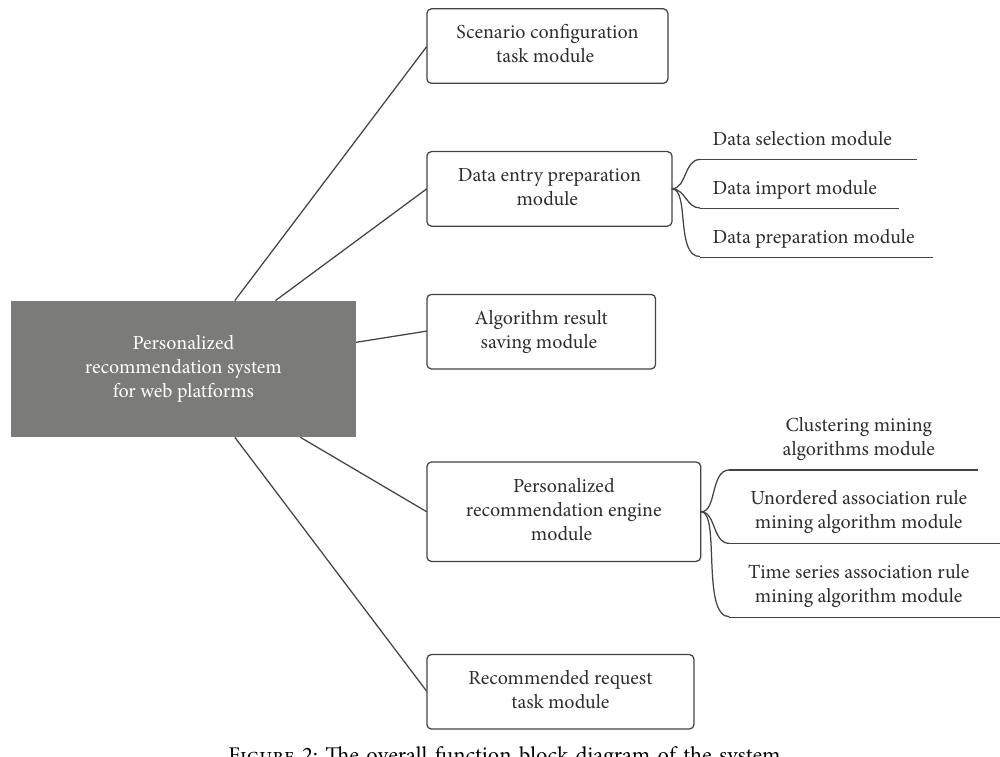
Figure 2: The overall function block diagram of the